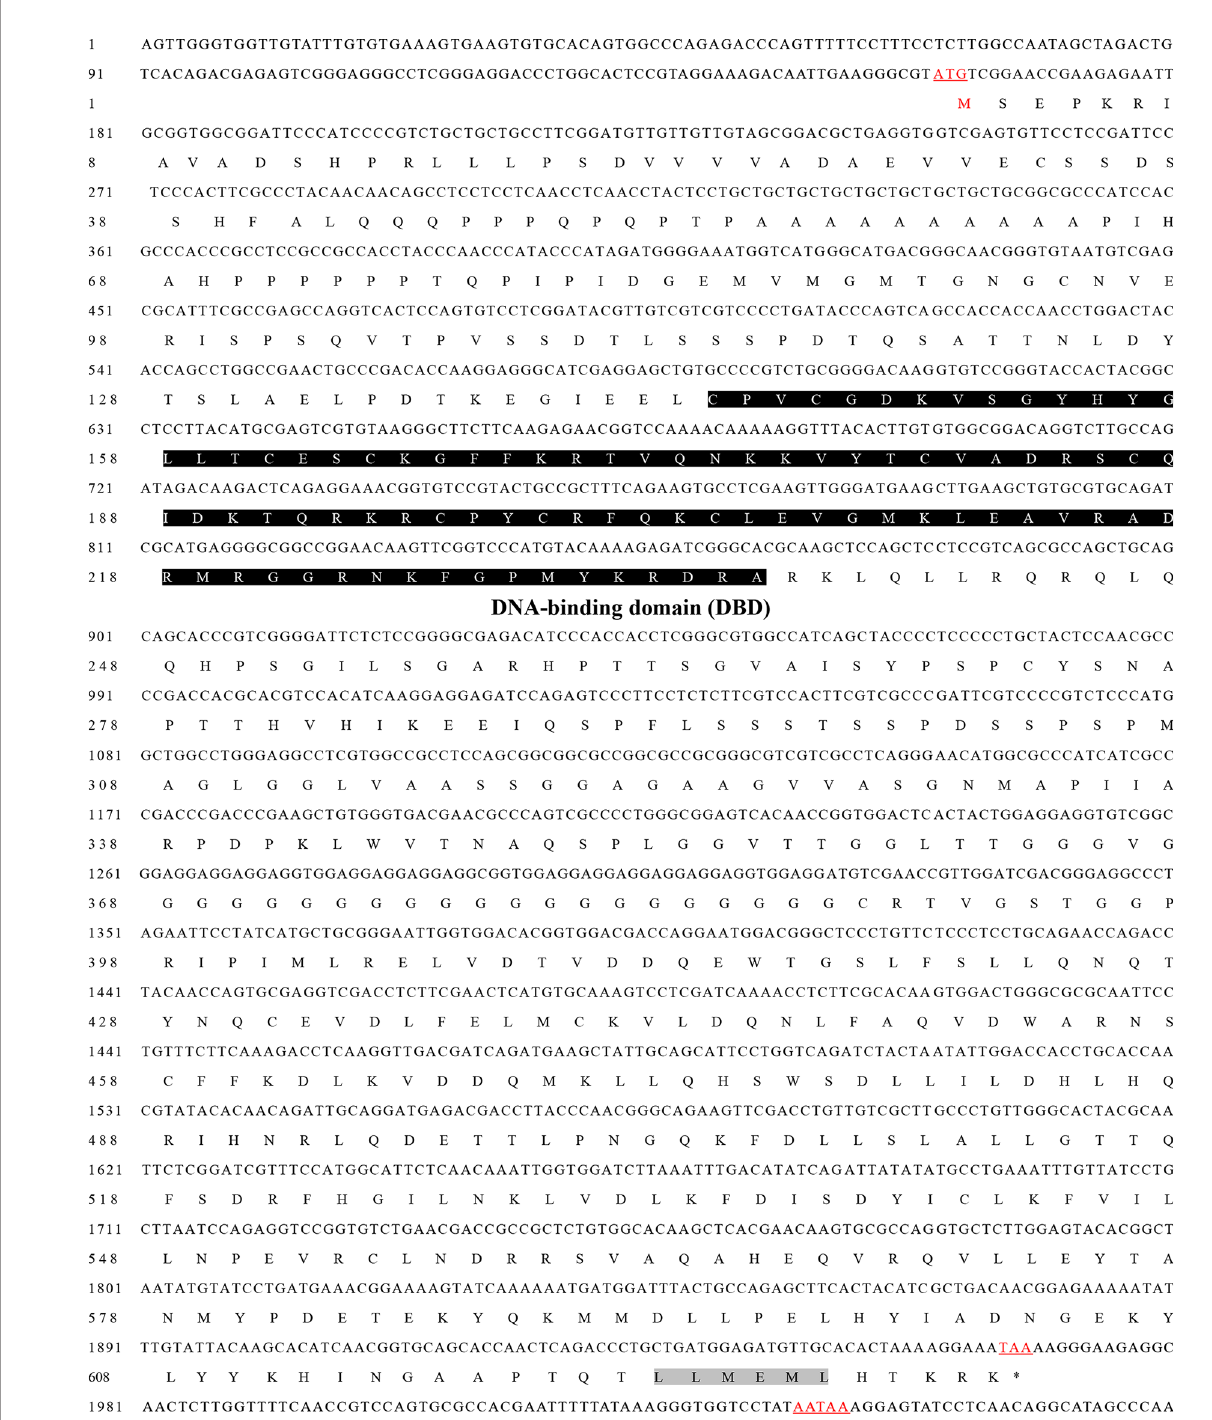
FIGURE 1 | The nucleotide and amino acid sequences of the MnFtz-f1 gene in M. nipponense . The numbers on the left of the sequence indicate the positions of nucleotides and amino acids. The amino acids are presented as one-letter symbols and shown below their codons in each line. The starting codon (ATG) is underlined; the termination codon (TAA) is indicated by an asterisk (*); and the putative polyadenylation signal (AATAAA) is underlined. The DBD domain is marked with shadow.